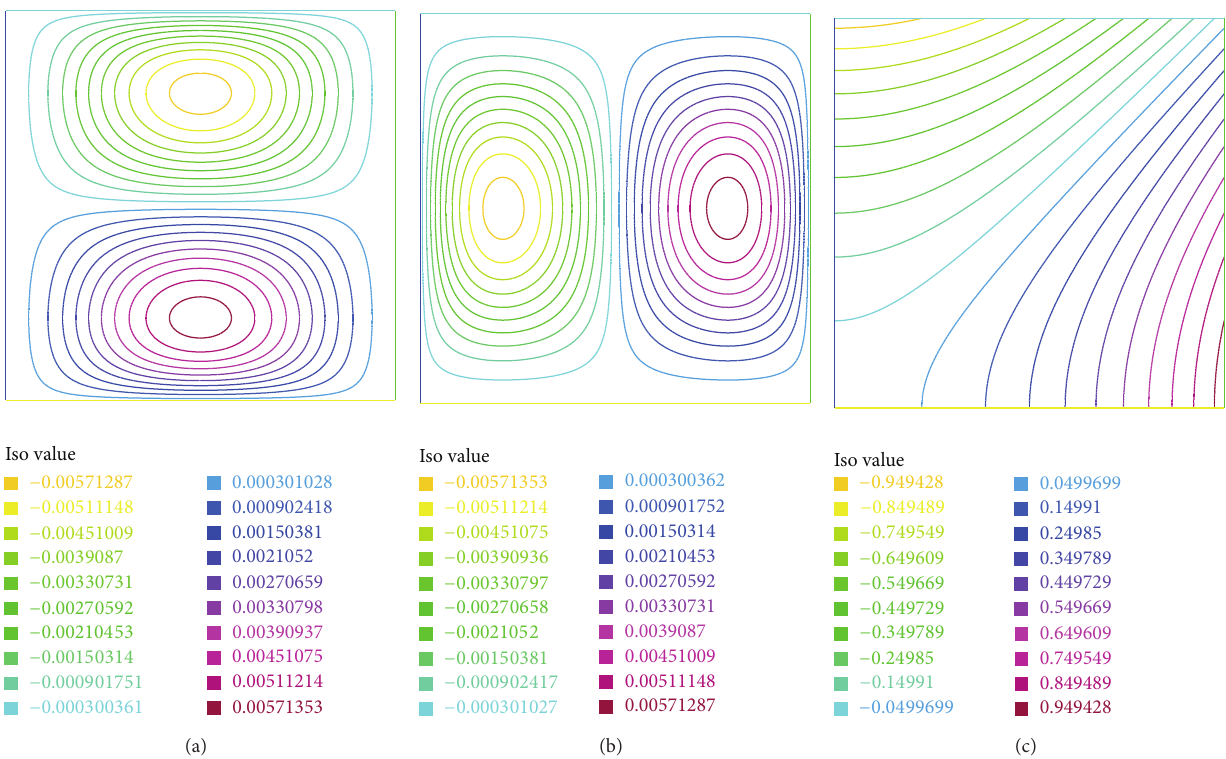
Figure 2: Contour plots of numerical solution by one-level stabilized method. From left to right: two components of velocity and